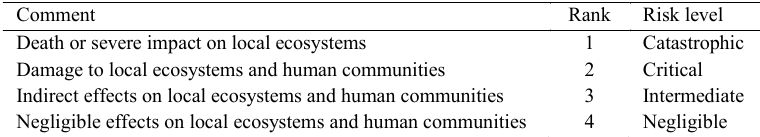
Table 4: Risk severity in PHA (Leggett 2012, Rooney et al., 1998)